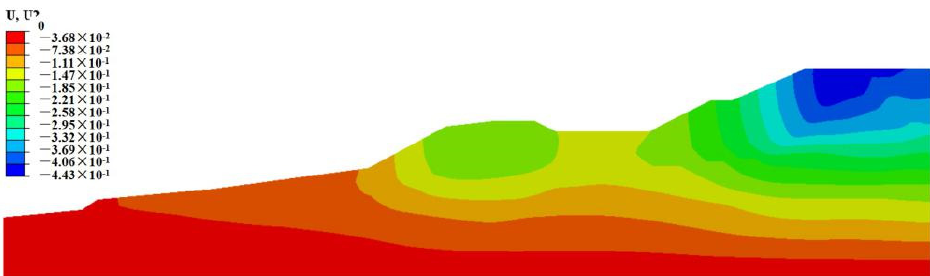
Figure 7. Slope plastic zone.